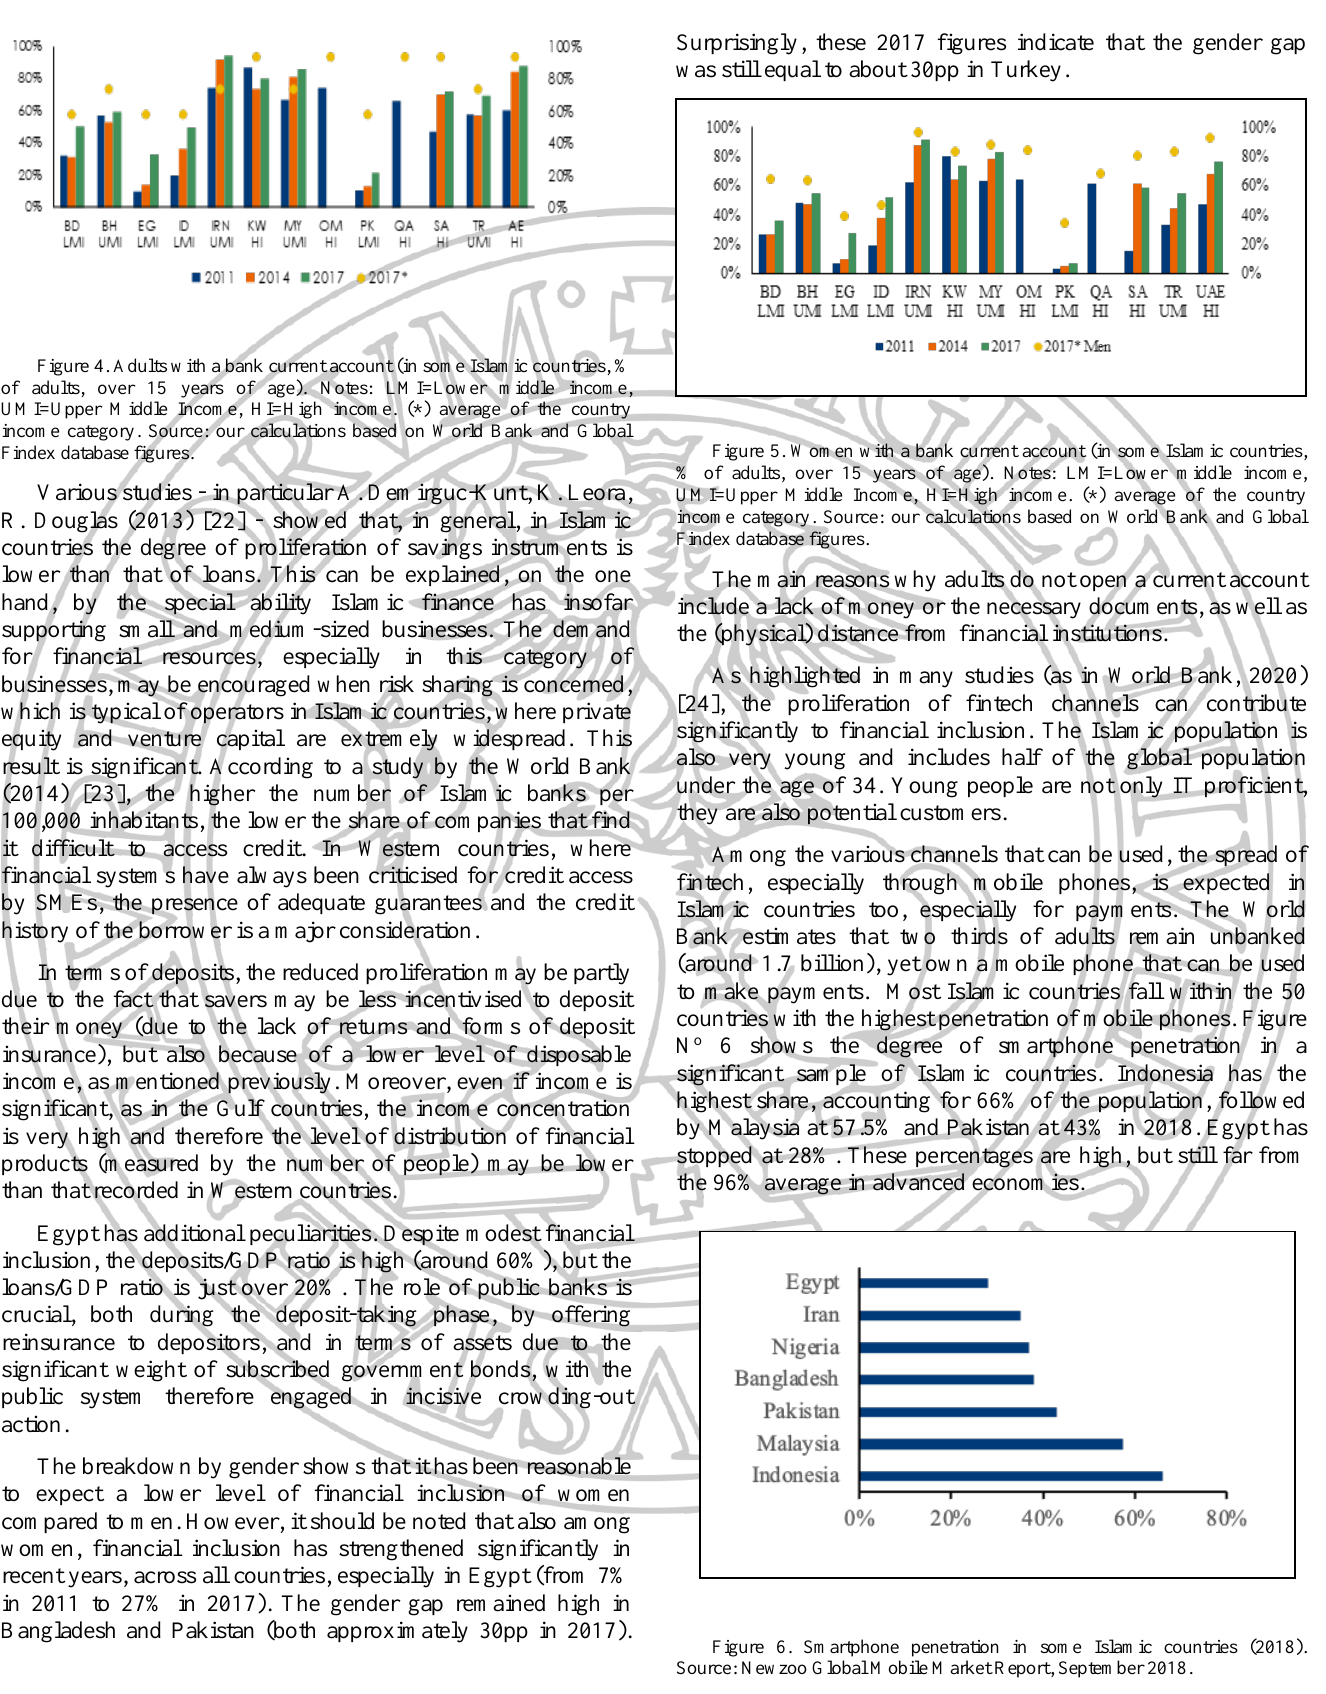
Figure 6. Smartphone penetration in some Islamic countries (2018). Source: Newzoo Global Mobile Market Report, September